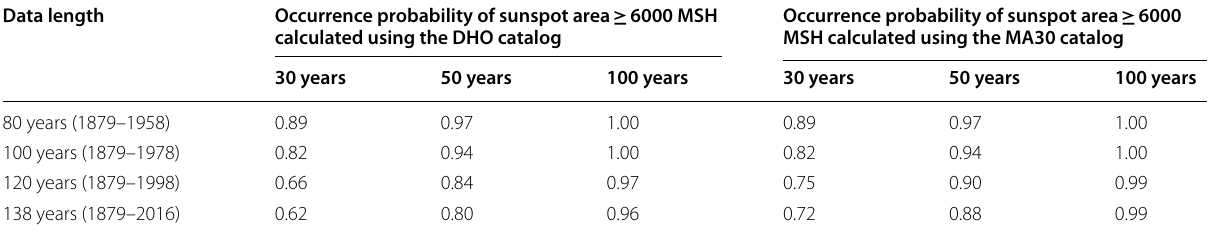
Table 4 Probabilities of a sunspot group with area ≥ 6000 MSH for next 30-, 50-, and 100-year periods for 80-, 100-, 120-, and 138-year data sets in the DHO and MA20 catalogues Data length